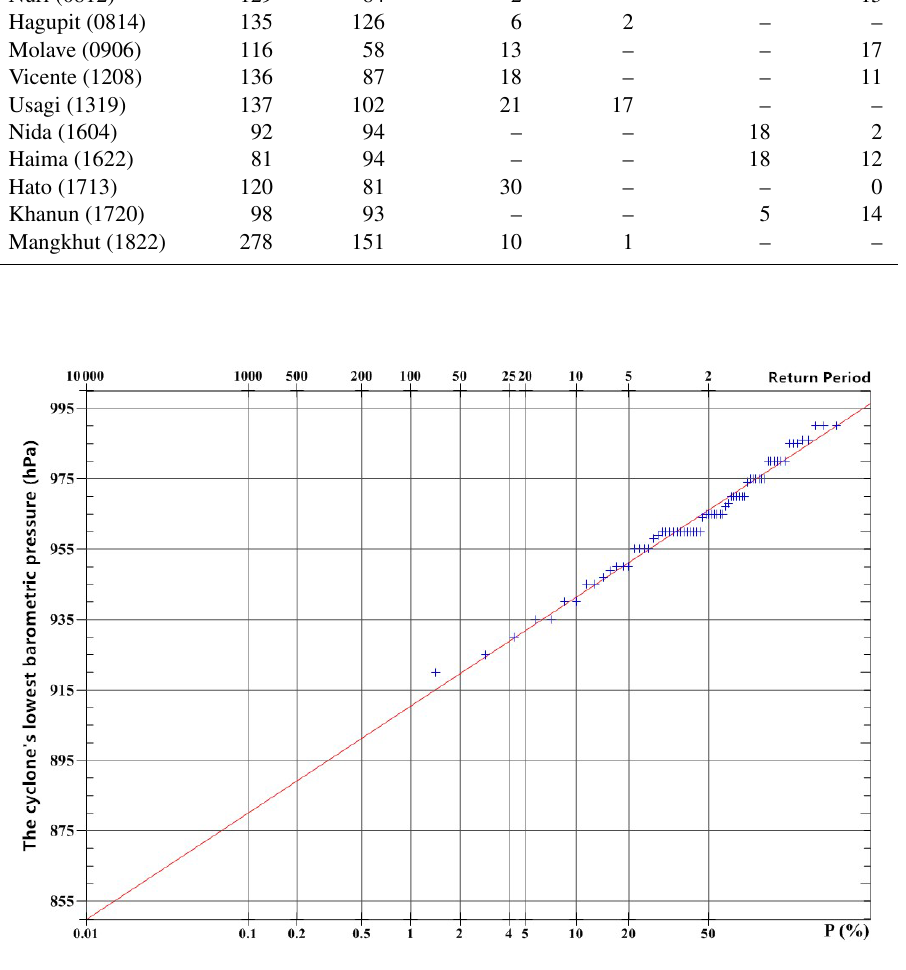
Figure 6. The relation between the return period and the central pressure of typhoons on extreme value distribution Type I, which struck coastal areas of Huizhou city from